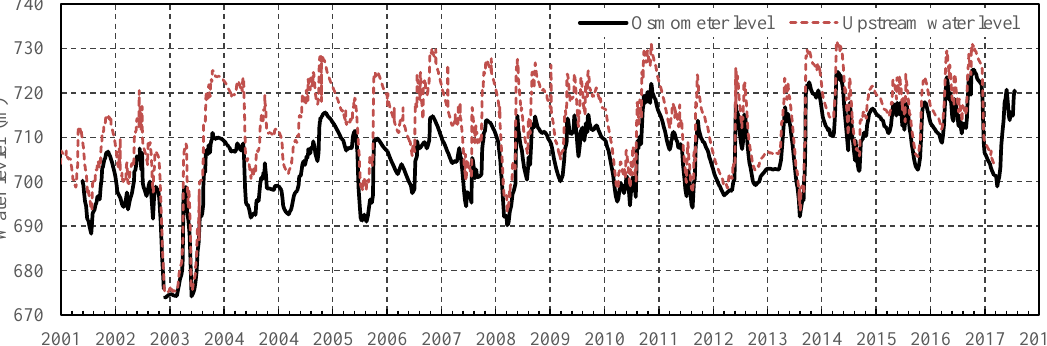
Figure 8. The hydrograph of the upstream water level and osmometer level of B2.